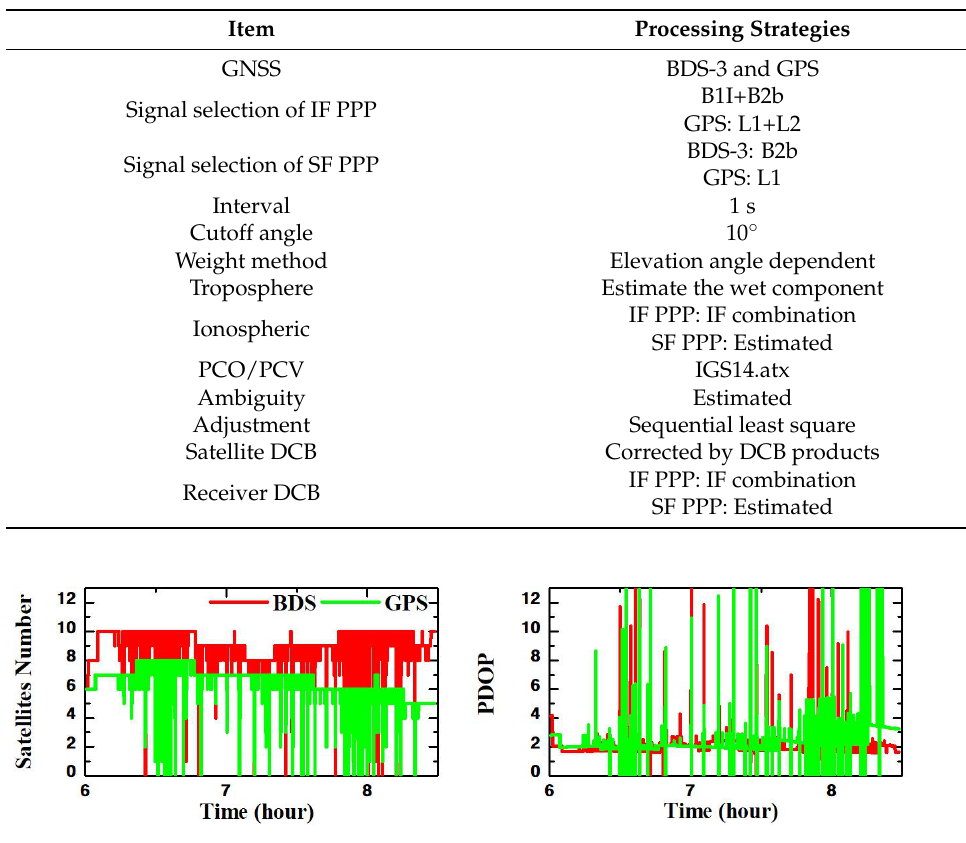
Figure 13. Number of visible satellites and PDOP values during the dynamic test.